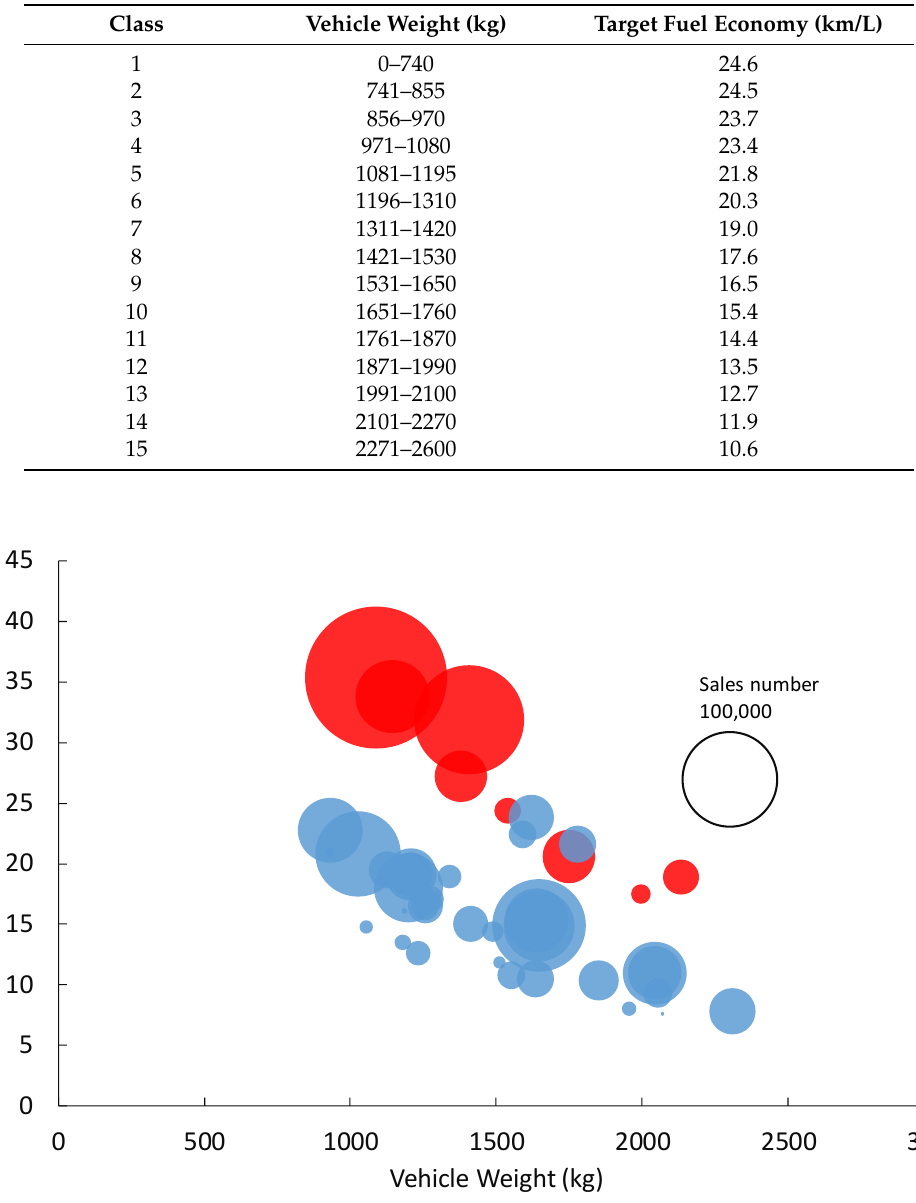
Figure A2. The relationships between fuel efficiency by vehicle model, vehicle weight, and the number of vehicle sales by model for Honda. Table A1. Weight categories. Class